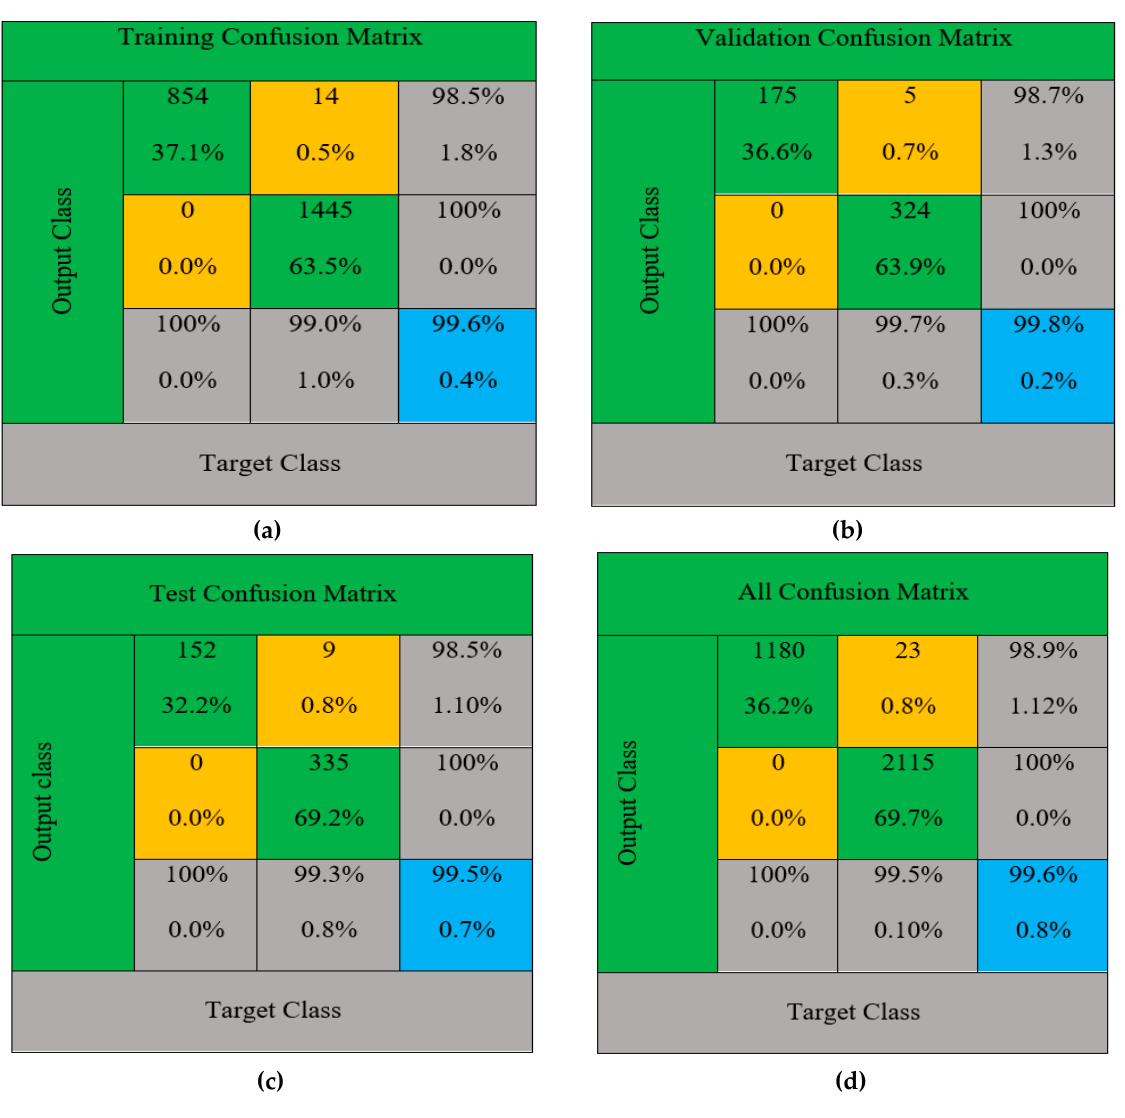
Figure 5. Confusion matrix of classification results: ( a ) training, ( b ) validation, ( c ) test, and ( d ) full.